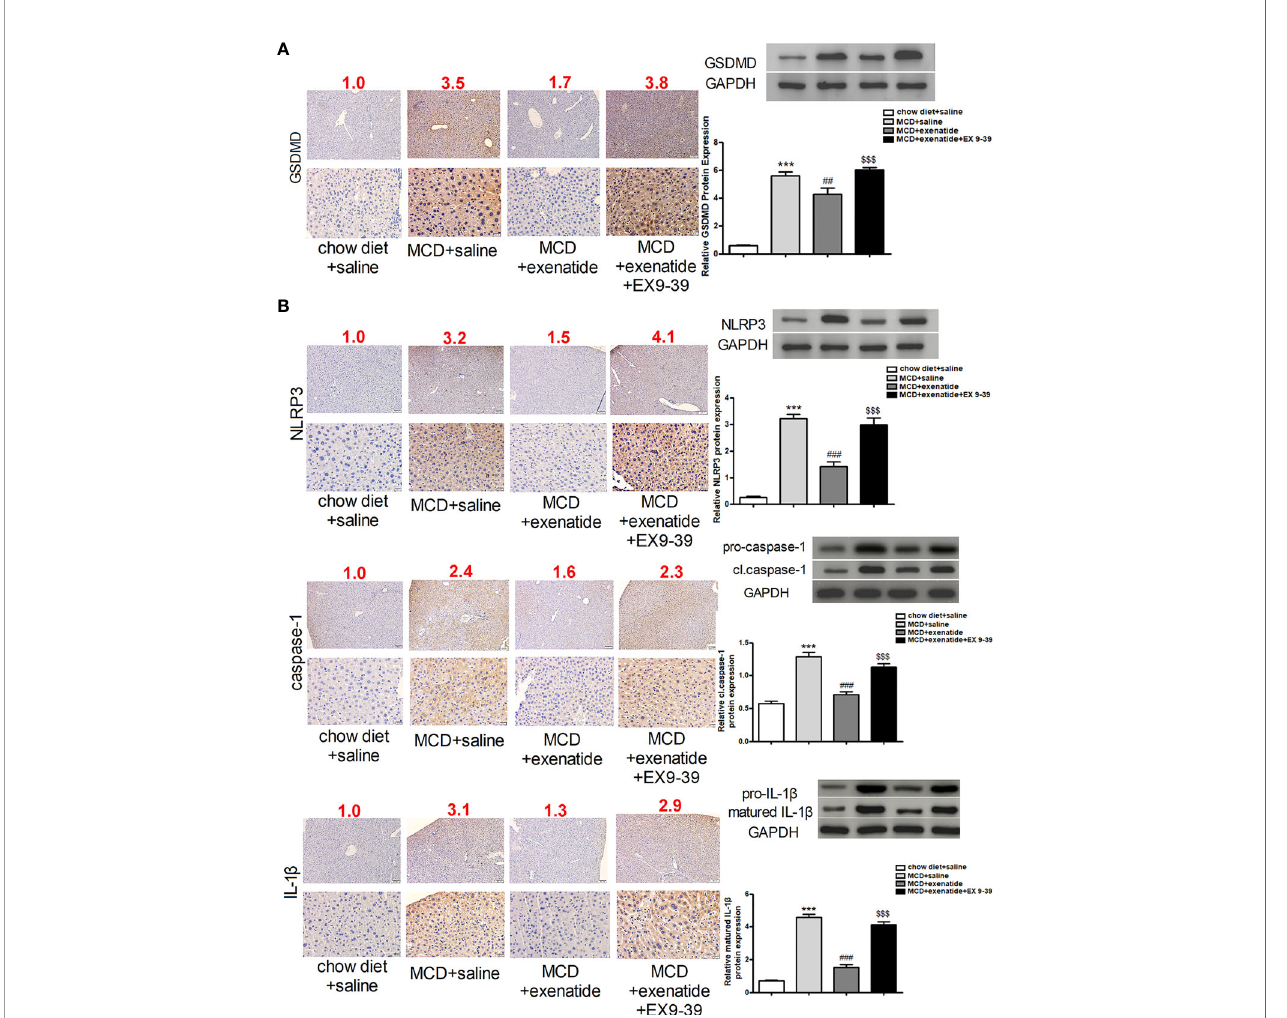
FIGURE 4 | Inhibition of the pyroptosis signaling pathway by exenatide in NASH. (A) Representative immunohistochemistry image of GSDMD. Protein expression levels of GSDMD in HepG2 cells as determined by western blotting. (B) Representative immunohistochemistry image of NLRP3, caspase-1, and IL-1 b . NLRP3, caspase-1, and IL-1 b protein expression levels were detected by western blotting. The numbers above each picture (shown in red) indicated the relative staining intensity as quanti fi ed by ImageJ. ***p < 0.001 vs. chow diet + saline; ### p < 0.001 vs. MCD + saline; $$$ p < 0.001 vs. MCD + exenatide (n = 6). Data are expressed as the mean ±